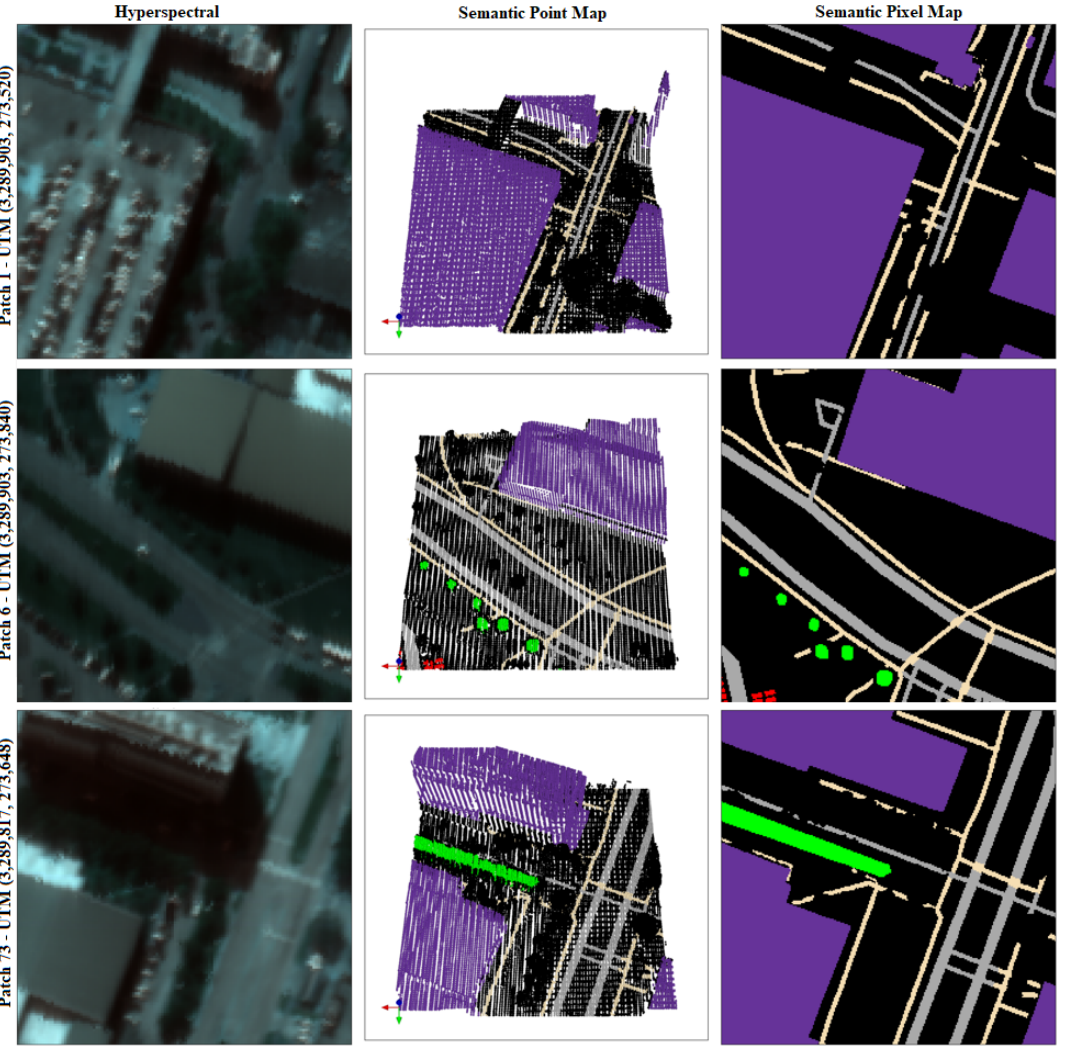
Figure 4. Three example multimodal data samples comprised of co-registered ( Left ) hyperspectral, ( Center ) lidar point cloud, and ( Right ) a semantic point map. The semantic point map is provided to better visualize raw point cloud